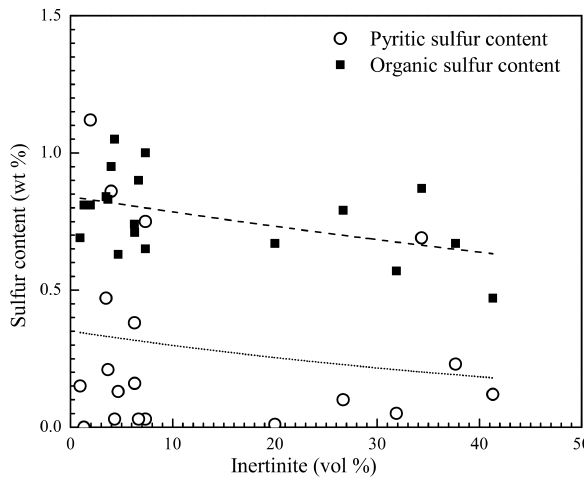
Figure 16. Relationship between inertinite and sulfur contents.